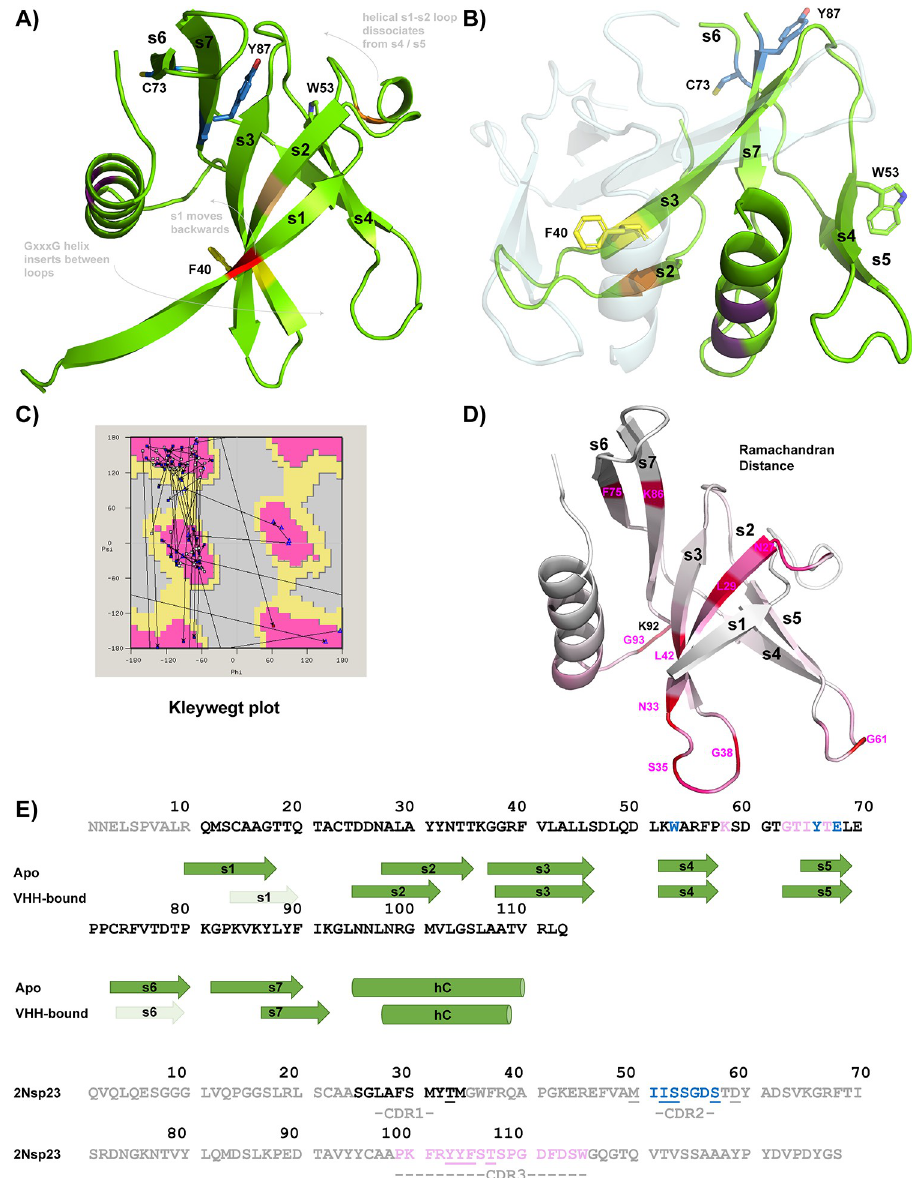
Fig 2. Architectural changes to the nsp9 cov19 fold within the VHH 2nsp23 -bound complex. A) Cartoon representation of the canonical coronaviral nsp9 fold with structural elements labelled. The position of key residues are noted with coloured highlights. B) An equivalent representation of a subunit of the VHH-bound nsp9 cov19 structure is displayed showing the opening of the mini β -barrel and insertion of the α C helix between the s2-s3 and s4-s5 loops. C) Kleywegt plot highlighting the extent to which residues undergo movements in Ramachandran space. D) The Ramachandran distances between the two states are mapped onto the canonical nsp9 cov19 structure using a white- > pink- > red gradient where the upper end of the scale is theoretical maximum. The identity of hinge residues are labelled. E) Top : The extent of secondary structural elements within each state of nsp9 cov19 are displayed under its sequence. Bottom : the sequence of 2nsp23 is shown with CDR loops coloured and labelled. VHH 2nsp23 residues interacting with nsp9 are underlined and their corresponding interaction partners coloured according to CDR